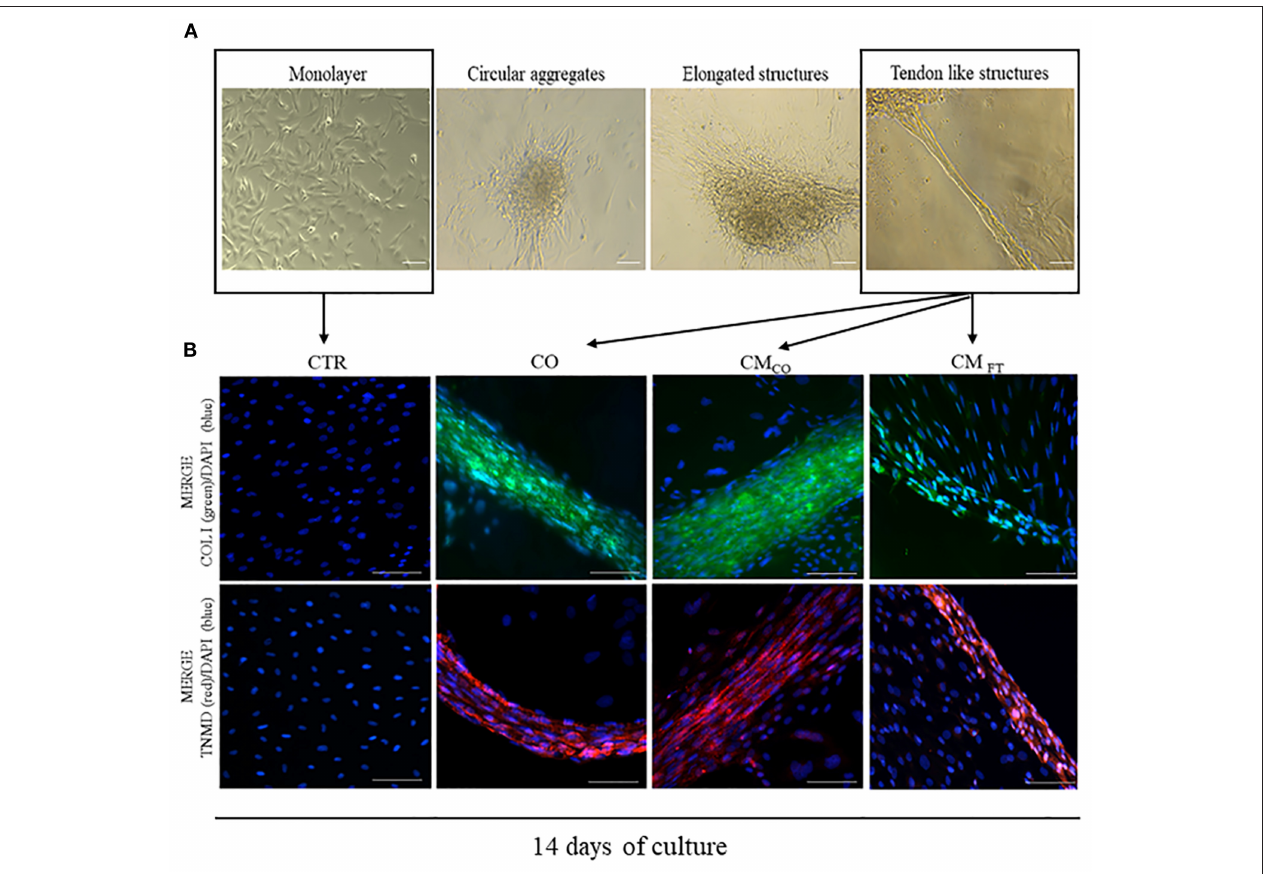
FIGURE 2 | (A) Representative images of different cell aggregates developed by AEC cultured under CTR and different teno-inductive (CO and CM) cultural conditions. Images were obtained with Olympus microscope IX-50 and processed with Image-Pro Insight software. Magnification 10X, scale bar 100 µ m. (B) Representative immunofluorescent images displaying the main cell organization after 14 days of culture as CTR, CO, CM CO. and CM FT , respectively. AEC under CTR condition after 14 days lead a confluent monolayer negative for both COL I and TNMD. On the contrary, CO, CM CO , and CM FT promote formation of COL I and TNMD positive 3D structures even if only in CO and CM CO both the proteins reach a high concentration combined with an extracellular localization. Representative IHC images of COL I (green color) and TNMD (red color) protein expression in AECs after 14 days of culture under different experimental conditions. Nuclei were counterstained with DAPI (blue color). Magnification 20X, scale bar: 100 µ